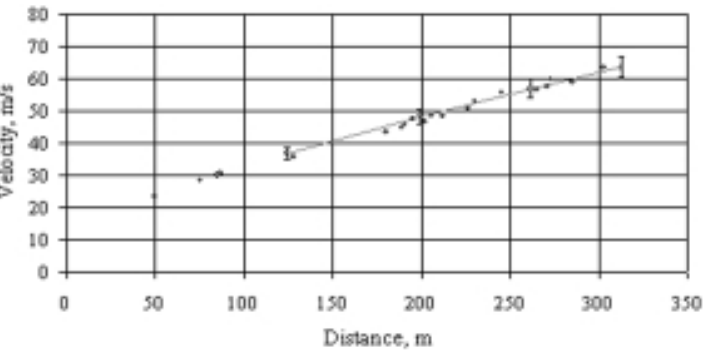
Fig. 6. Voltage over time during firing process of the mortar simulator.